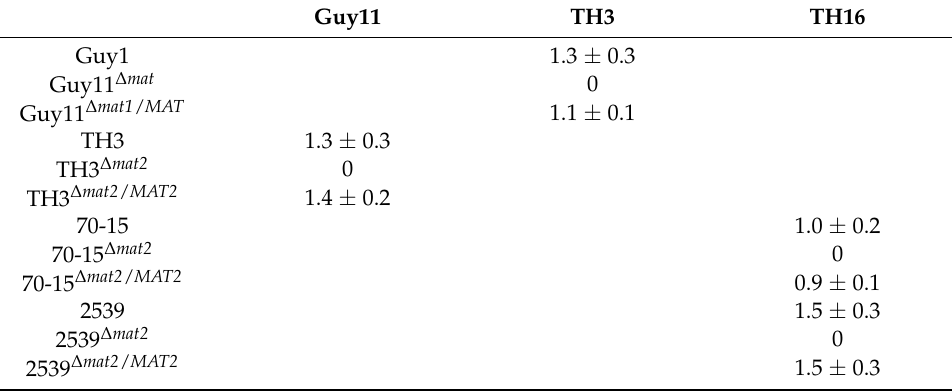
Table 1. The numbers of perithecia formed in the cross of MAT loci mutants, the wild-type strains and complement strains on OMA plates ( × 10 4